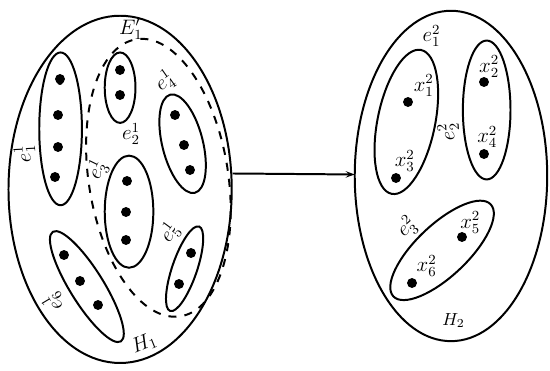
Figure 14. The internal and external zoom-out